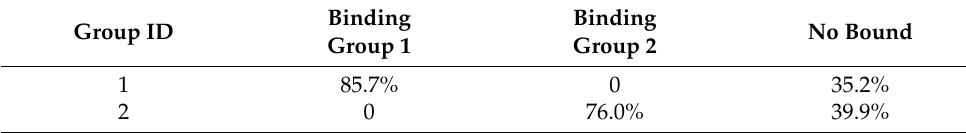
Table 3. The percentage of successful positioning in three testing cases.